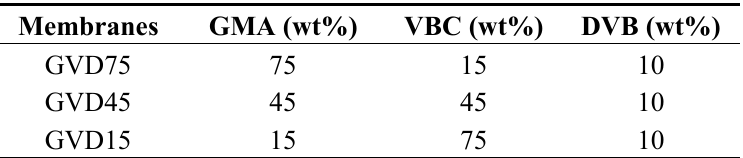
Table 1. Composition of monomer solutions.